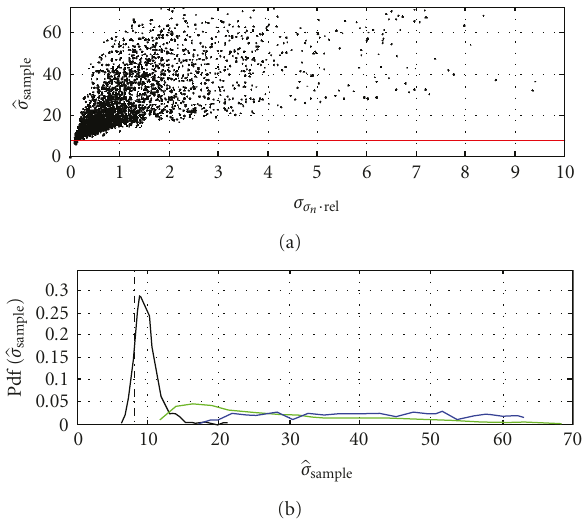
Figure 2: Dependence of noise STD estimates on relative CRLB for the image 14 from the TID2008 database. (a) Sample STD, σ 2 σ n · rel (cid:19) σ × 7 SW versus σ sample , within a 7 σ n · rel ; (b) distribution of ≤ σ three cases: σ σ σ n · rel · max (black curve), σ σ n · rel > 2 n · rel (green curve) and σ σ (blue > 4 · σ σ n · rel n · rel · max